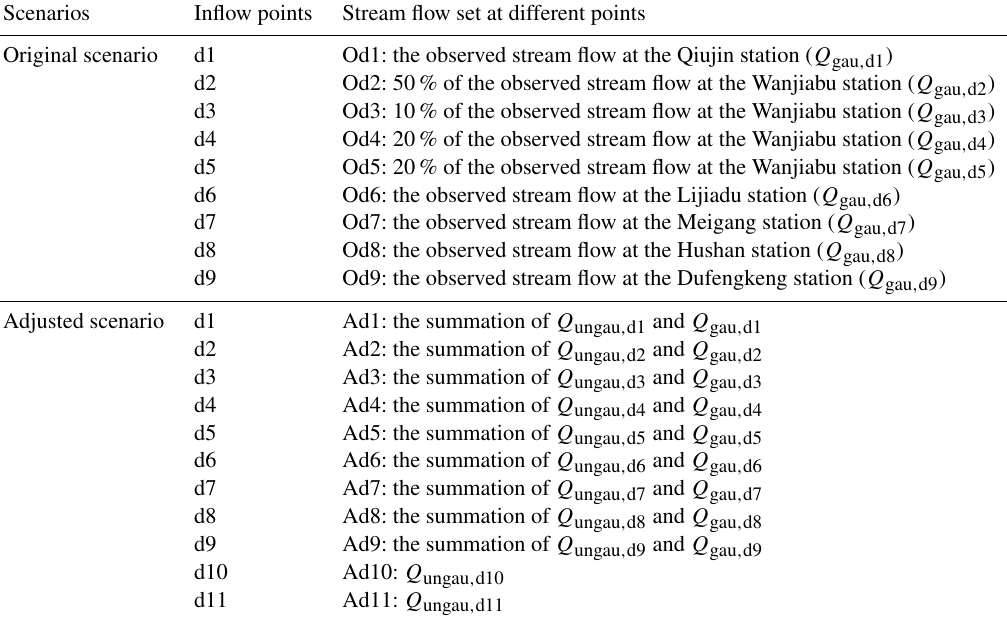
Table 1. The upstream boundary conditions of the Delft3D model in the original and adjusted scenarios. Od1, Od2, Od3, Od4, Od5, Od6, Od7, Od8, and Od9 represent the stream flow set at d1, d2, d3, d4, d5, d6, d7, d8, and d9, respectively, in the original scenario. Ad1, Ad2, Ad3, Ad4, Ad5, Ad6, Ad7, Ad8, Ad9, Ad10, and Ad11 represent the stream flow set at d1, d2, d3, d4, d5, d6, d7, d8, d9, d10, and d11, respectively, in the adjusted scenario. b1, b2 ... , and b13 represent the sub-basins in the PLUZ (Fig. 3b). Q gau ,d gauged and ungauged stream flow gathering to the point of d i , respectively. Q ungau ,d Table